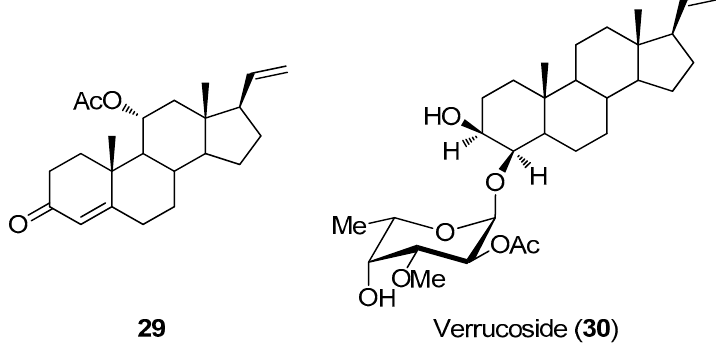
Figure 9. Pregna-4,20-dien-11 α -ol-3-one acetate ( 29 ) and verrucoside ( 30 ).